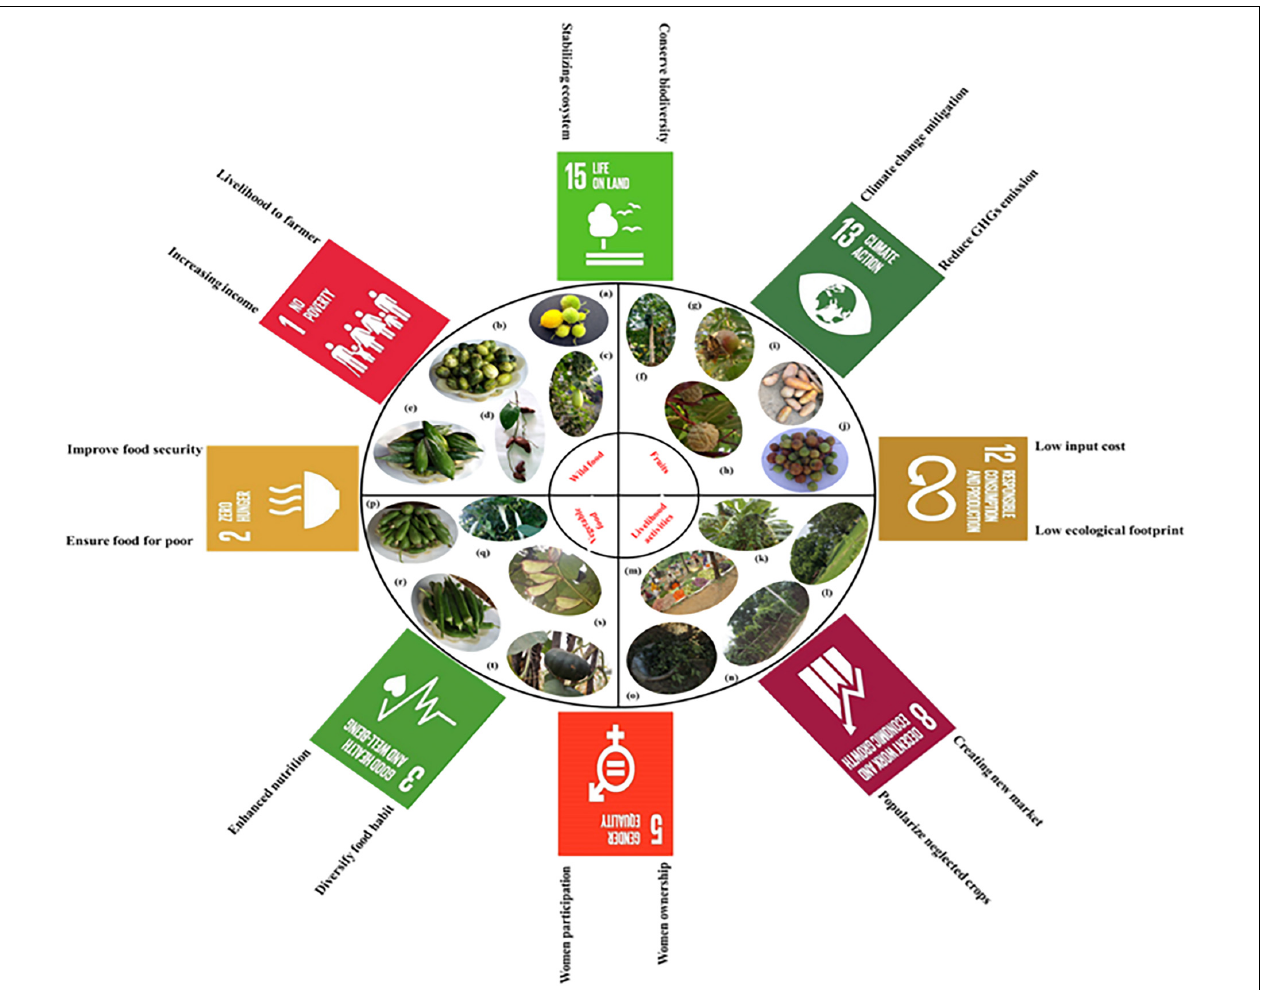
FIGURE 8 | Schematic representation of indigenous home garden contribution to achieving the target of Sustainable Development Goals (SDGs) providing food, fruit vegetable and livelihood for food security. These services contribute to achieving the targets of GDGs supporting SDGs 1 (no poverty), SDGs 2 (zero hunger), SDGs 3 (good health and well-being), SDGs 5 (gender equality), SDGs 8 (decent work and economic growth), SDGs 12 (responsible consumption and production), SDGs 13 (climate action) and SDGs 15 (life on land). Pictorial image show plant species and their contribution, (a) Momordica dioica , (b) Cucumis Callosus , (c) Sechium edule , (d) Dioscorea bulbifera , (e) Trichosanthes cucumerina (wild), (f) Carica papaya , (g) Punica granatum , (h) Annona squamosal , (i) Cucumis sativus , (j) Ziziphus xylopyrus , (k) Musa paradisiaca as ornamental plant, (l) Mangifera indica canopy for shed, (m) selling of garden vegetable in traditional market, (n) fencing by garden, (o) branches of Woodfordia fruticose as fodder, (p) Abelmoschus esculentus , (q) Cucurbita pepo , (r) Luffa operculata , (s) Lablab purpureus , (t) Trichosanthes cucumerina